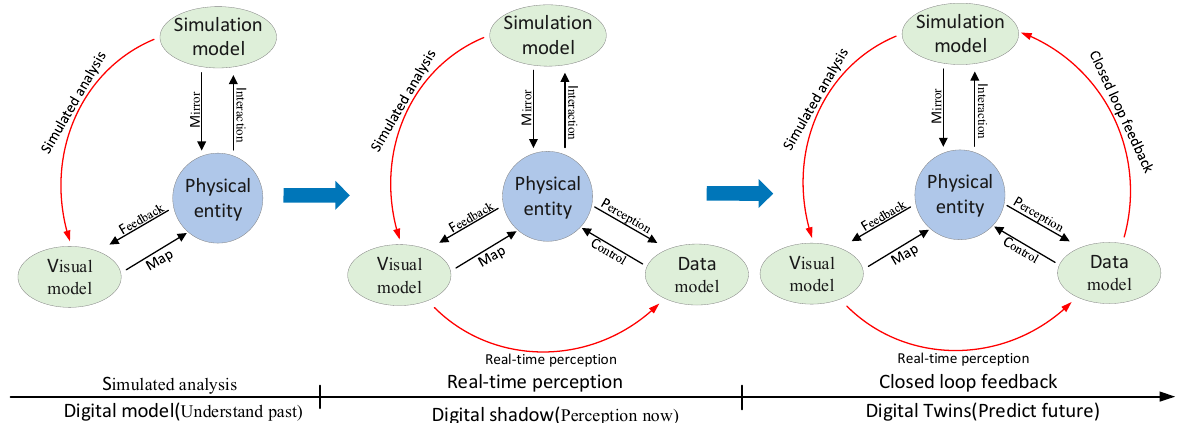
Figure 1. The evolution of DTs.